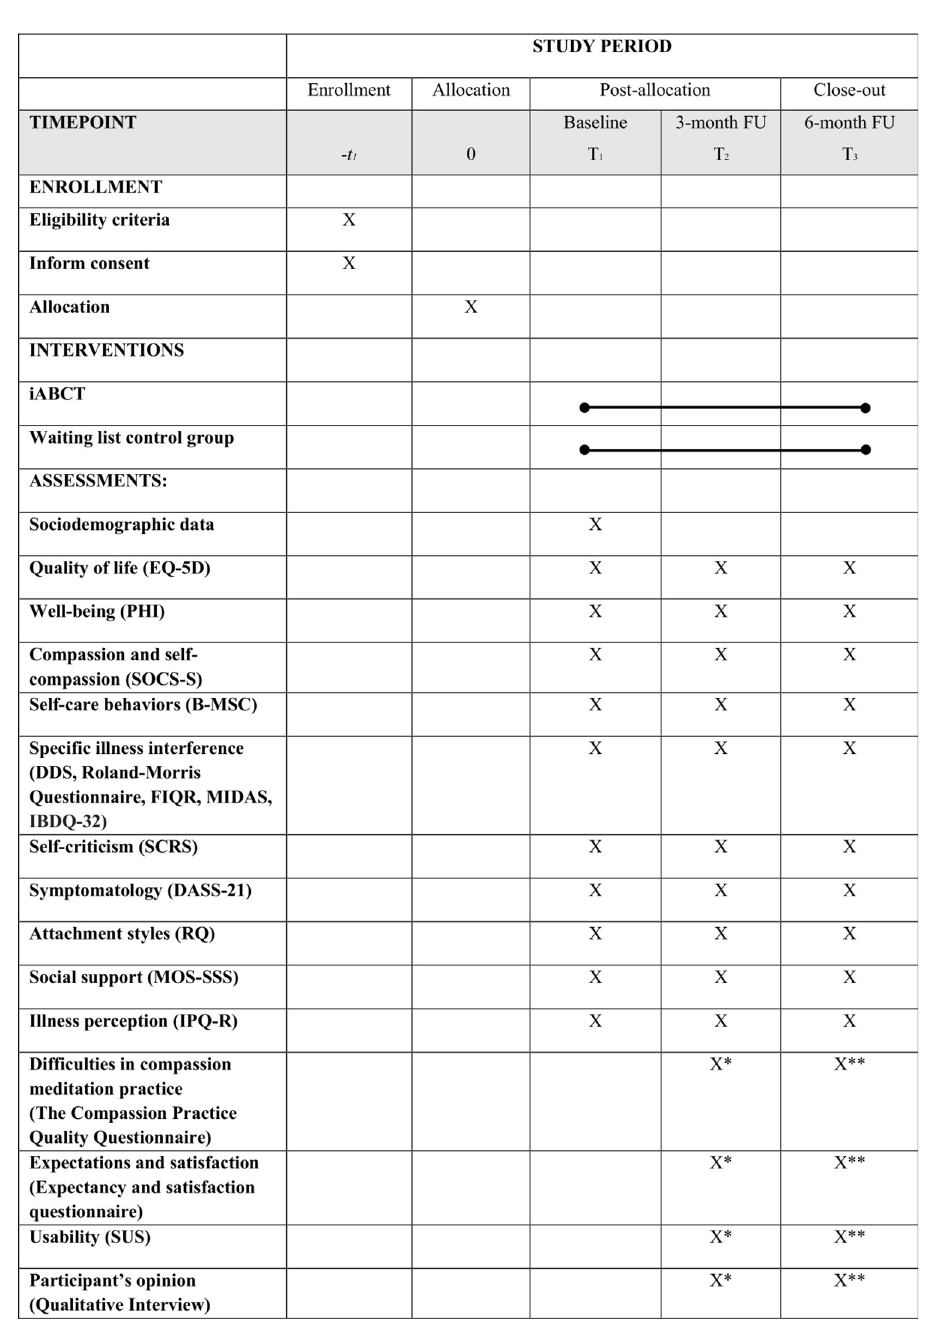
Fig 1. SPIRIT flow diagram: Schedule of enrolment, interventions and